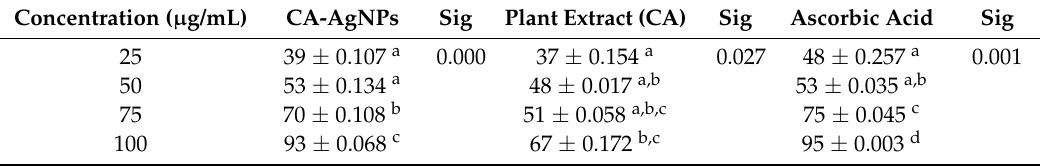
Table 4. Antioxidant